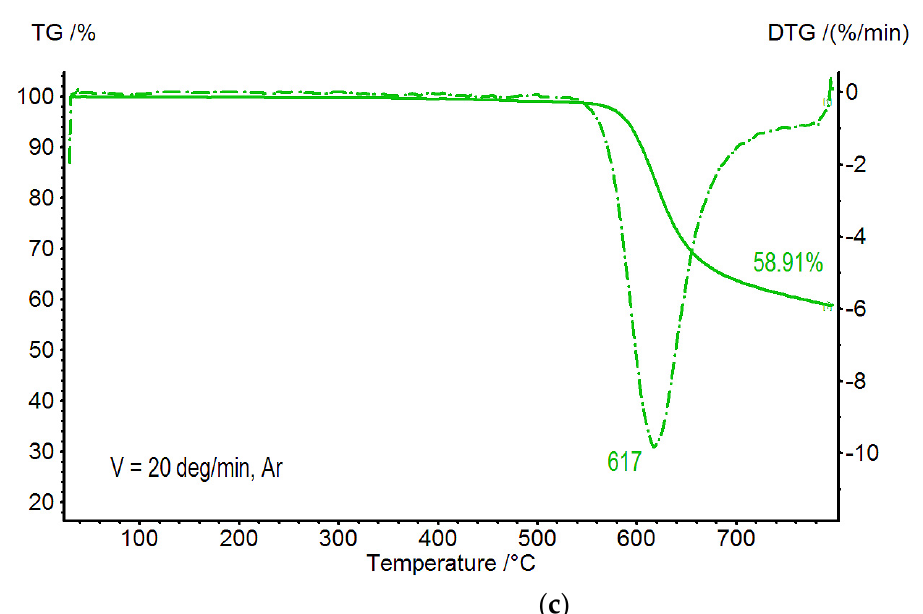
Figure 1. TGA and DTG curves: ( a ) copoly(urethane-imide) [(imide) 11 -(polyurethane)] m thermalized for 30 min at temperatures: 170 °C (green curves), 300 °C (blue curves), 350 °C (red curves), Fig.; ( b ) multiblock segmental copolyurethane-imide (Scheme 2), Fig.; ( c ) laboratory sample of poly-(4,4 ′ - oxydiphenylene) pyromellitimide. Note: The heat resistance indices τ 5 and τ 10 are the corresponding 5 and 10% weight loss of the samples.